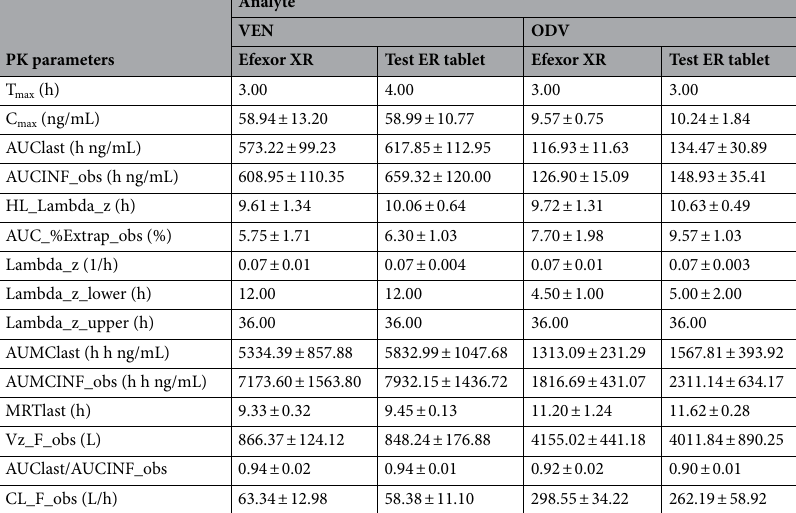
Table 11. PK parameters of VEN and free ODV in New Zealand white rabbits (n = 4). T max Time of maximum observed concentration, C max Maximum observed concentration, occurring at time T max , AUClast Area under the curve from the time of dosing to the time of the last measurable (positive) concentration, AUCINF_obs AUC from time of dosing extrapolated to infinity, based on the last observed concentration, HL_Lambda_z Terminal half-life [ln(2)/λ z ], AUC_%Extrap_obs Percentage of AUCINF_obs due to extrapolation from Tlast to infinity, Lambda_z First-order rate constant associated with the terminal (log-linear) portion of the curve [Estimated by linear regression of time vs. log concentration], Lambda_z_lower Lower limit on time for values to be included in the calculation of Lambda Z, Lambda_z_upper Upper limit on time for values to be included in the calculation of Lambda Z, AUMClast Area under the moment curve from the time of dosing to the last measurable (positive) concentration, AUMCINF_obs Area under the first moment curve (AUMC) extrapolated to infinity, based on the last observed concentration, MRTlast Mean residence time from the time of dosing to the time of the last measurable concentration, Vz_F_obs Volume of distribution based on the terminal phase, CL_F_obs Total body clearance for extravascular administration, where F is the fraction of dose